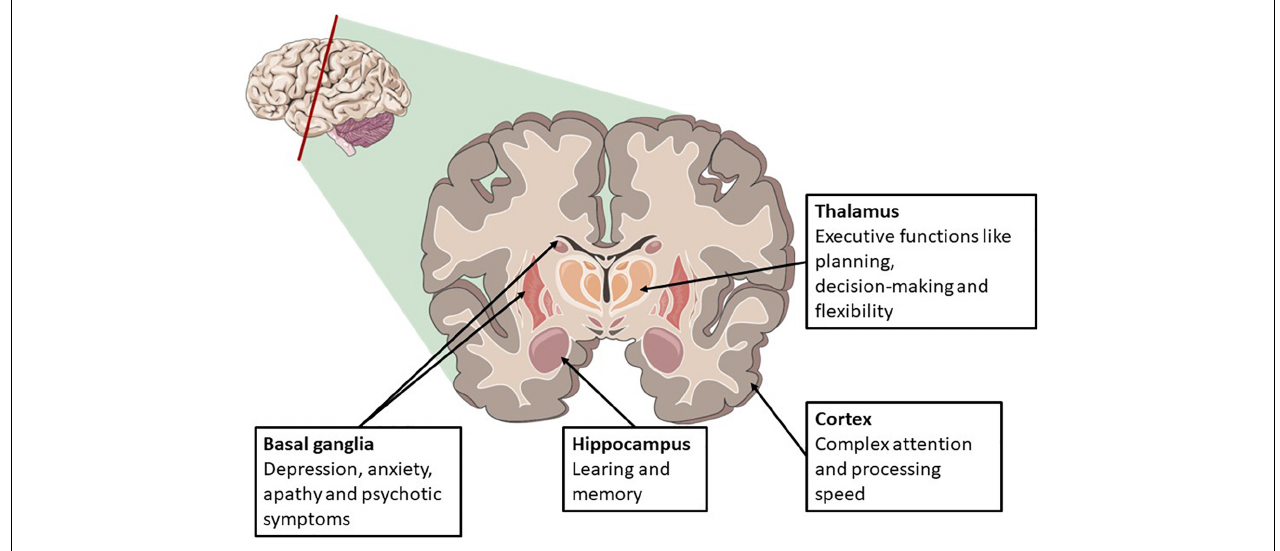
FIGURE 1 | Areas susceptible for global anoxic-ischemic brain injury and related cognitive symptoms. Illustration adapted from servier medial